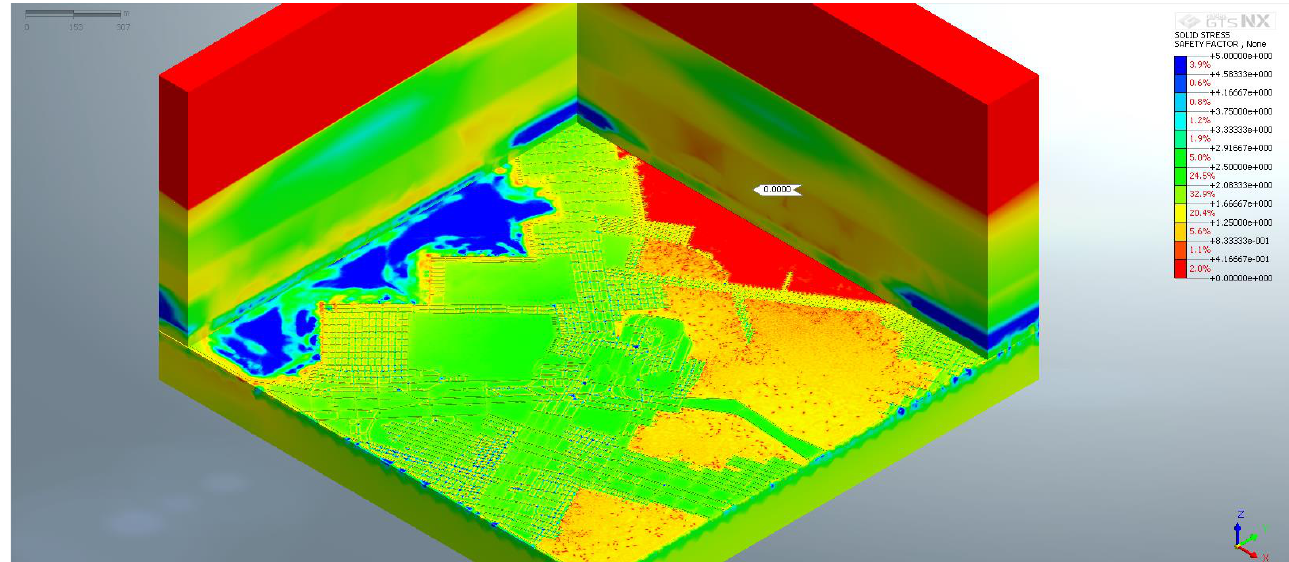
Figure 15. Distribution of the SF values within the immediate roof strata in the selected mining area (size of the model 2 km × 2 km × 1.5 km).